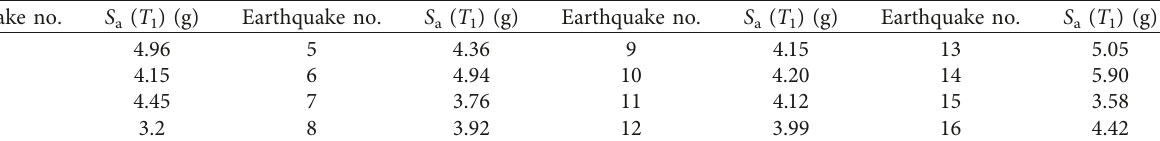
Table 7: Spectral accelerations of the structural collapse.